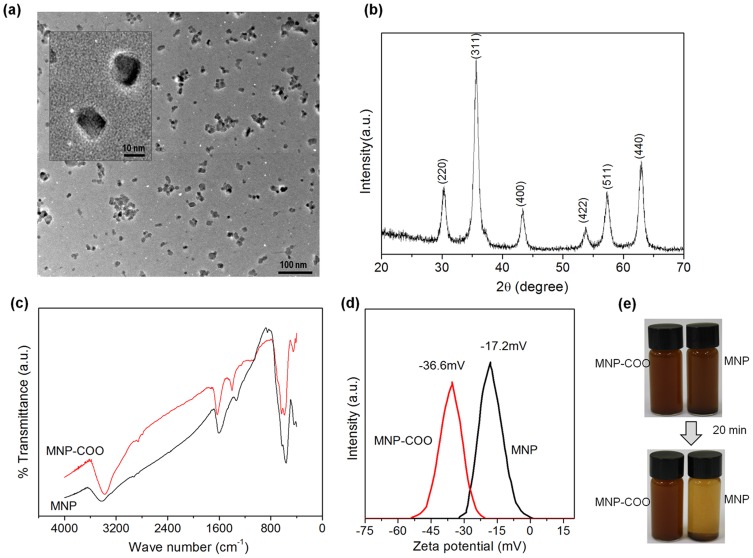
Characteristics of the MNPs prepared with citric acid functionalization.(a) TEM image showing ultrafine monodispersed nanoparticles with an average size of 12.0 nm. (b) XRD pattern with typical magnetite peaks. (c) FT-IR spectrum before and after the citric acid functionalization. (d) Zeta potential of the MNPs before and after the citric acid functionalization, showing more negatively charged with the functionalization. (e) Dispersion ability of the MNPs in distilled water and DCM/ethanol (a solvent used for the nanocomposite electrospinning with PCL), showing the citric acid functionalization increased stability significantly.